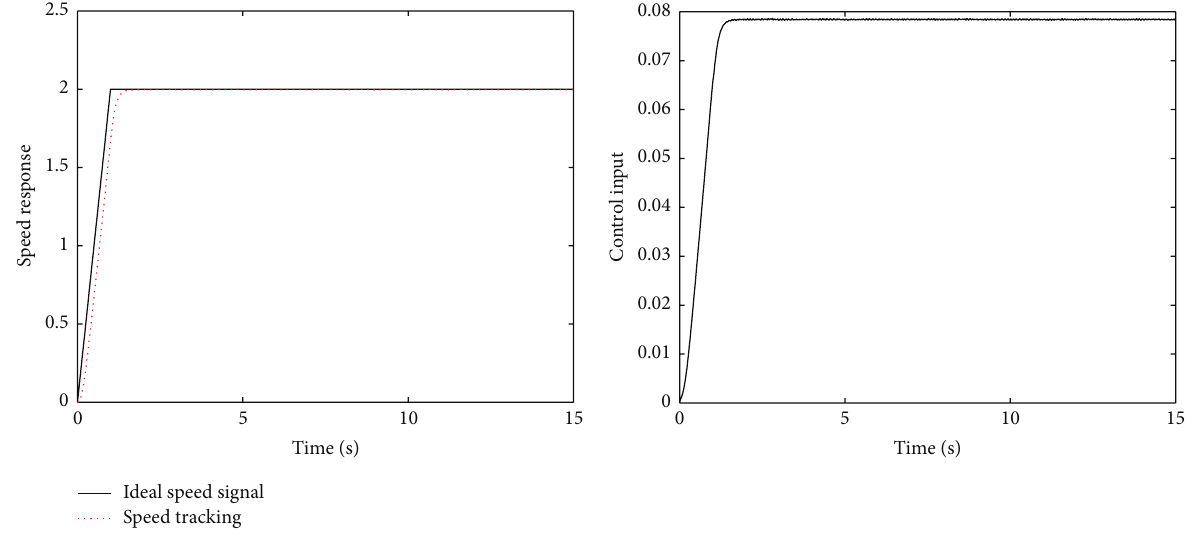
Figure 18: Simulation curve based on fuzzy sliding mode control at constant speed.